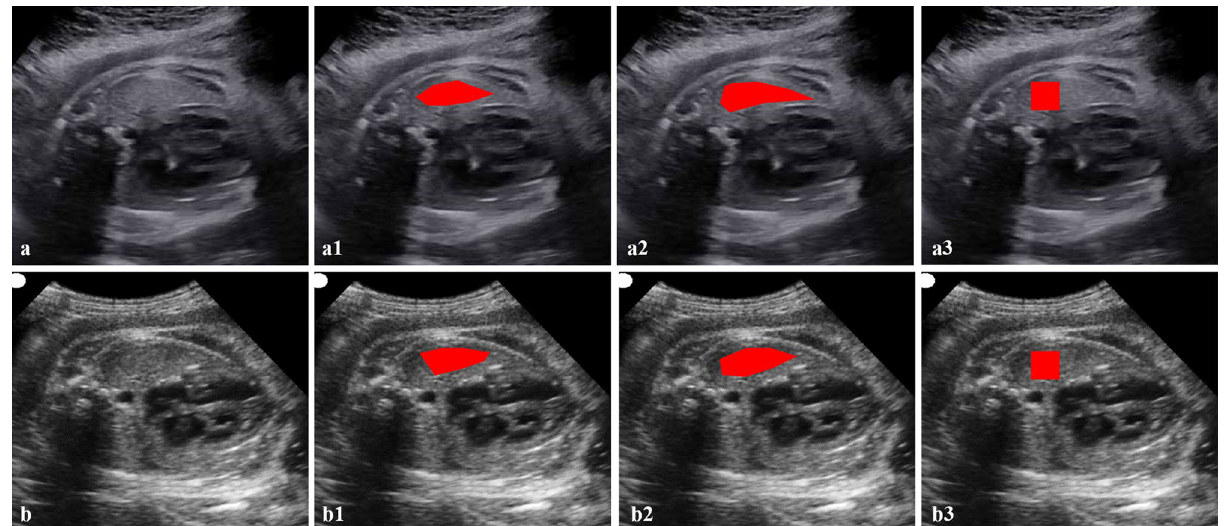
Figure 4. Fetal human lung ultrasound images with defined regions of interest. ( a,a1,a2,a3 ) Are images of training set. ( b,b1,b2,b3 ) Are images of testing set. ( a1,b1 ) Manual delineation (radiologist A ) of each lung. ( a2,b2 ) Manual delineation (radiologist B) of each lung. ( a3,b3) Square delineation (40 × 40 pixels) of each lung. ( a,a1,a2,a3 ) Image of left lung at 36 +1 weeks in woman with pre-eclampsia (PE). Cesarean delivery occurred 2 days after ultrasound examination, and baby was diagnosed with transient tachypnea of the newborn. The risk probability derived from the model is 0.829 (> 0.5). ( b,b1,b2,b3 ) Image of left lung at 34 +0 weeks in woman with gestational diabetes mellitus (GDM). Cesarean delivery occurred immediately after ultrasound examination, and baby was diagnosed with respiratory distress syndrome. The risk probability derived from the model is 0.843 (>